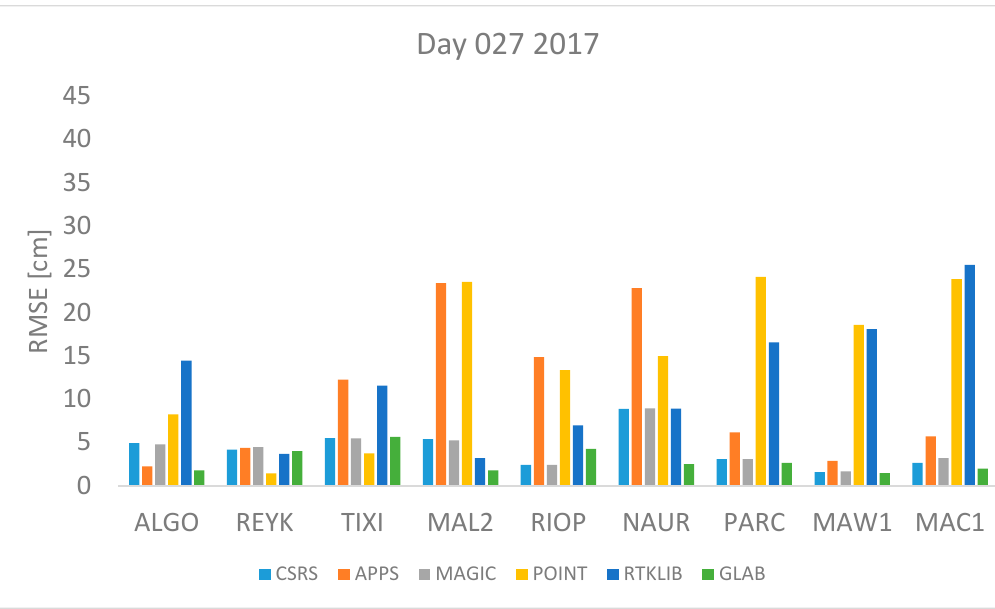
Figure 2. RMSE in centimeters for day 27 2017.